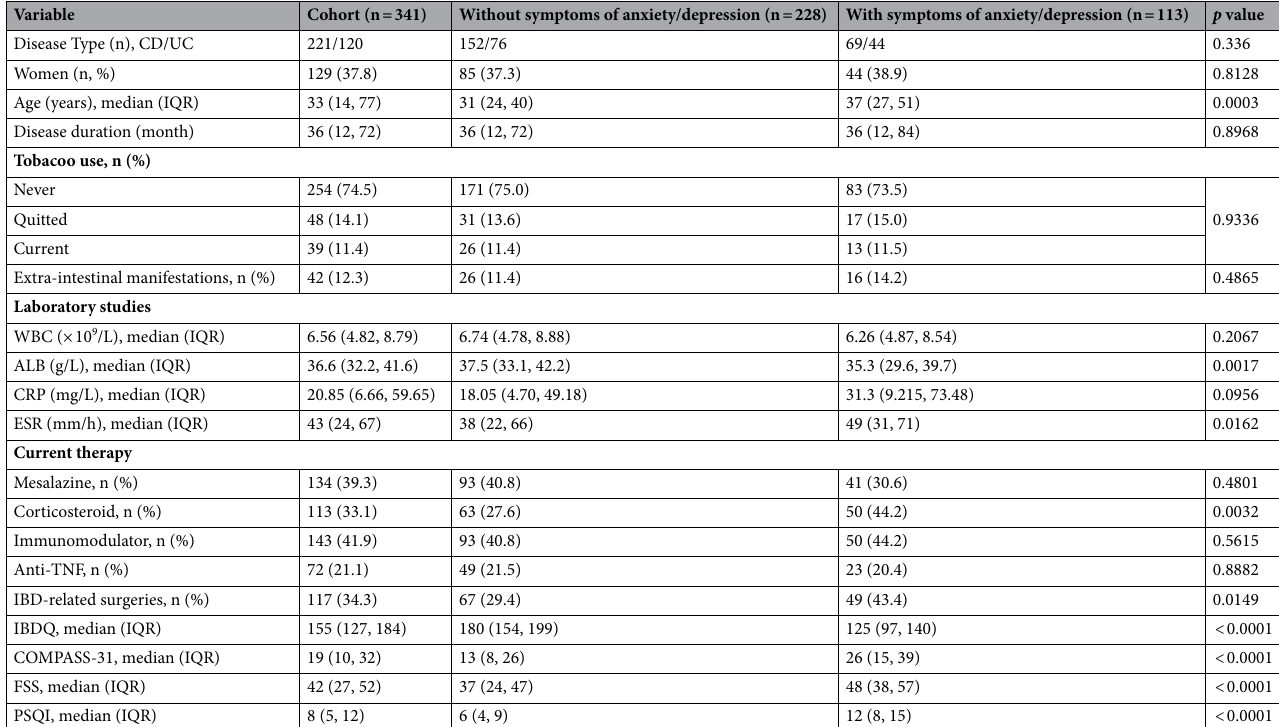
Table 1. Characteristics of the entire cohort. CD Crohn’s disease, UC ulcerative colitis, IBD inflammatory bowel disease, WBC white blood count, ALB albumin, ESR erythrocyte sedimentation rate, CRP C-reactive protein, TNF tumor necrosis factor, IBDQ inflammatory bowel disease questionnaire, COMPASS composite autonomic symptom score, FSS fatigue severity scale, PSQI Pittsburgh sleep quality index, IQR interquartile